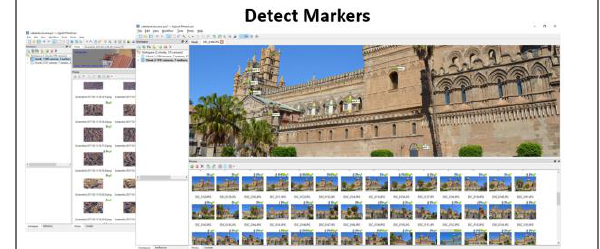
Figure 11. Detect Markers in Chunk 1 and Chunk 2